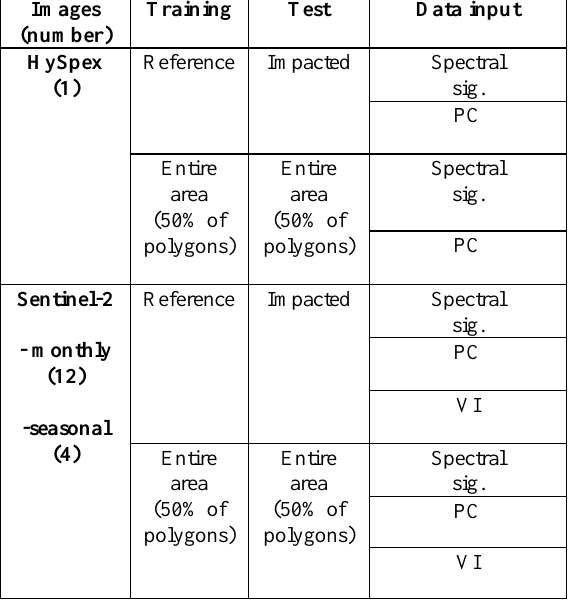
Table 3 . Scenarios of classification (PC: Principal Components, Spectral sig.: Spectral signature, VI: Vegetation Index). Individual or combined VI are